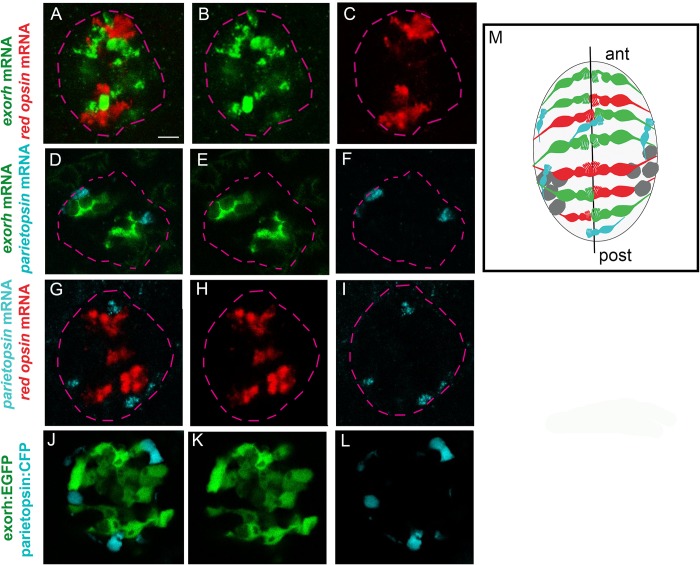
The zebrafish pineal gland contains three PhR subtypes.(A-I) Confocal sections of embryos double labeled for two of the three different opsin probes (exorh, PT, and red opsin). Nuclear staining (Topro3) was used to draw a mask delineating the pineal gland; these masks are shown on the panels (dotted pink lines). Embryos shown are 48 hpf. The images are falsely colored to show the exorh+ cells in green, the PT+ in blue, and the red+ in red. Anterior (“ant”) is on the top. Scale bar represents 10 μm. (J-L) Confocal sections of live Tg(exorh:EGFP)ja1;Tg(-2.2parietopsin:CFP) double-transgenic embryos (exorh:EGFP; parietopsin:CFP). Embryos shown are 96 hpf. (M) Schematic representation of the organization of the pineal gland with the orientation as in A-L. The midline is shown with a black line, projection neurons are in gray, and the color code for the PhRs is as in panels A-L. Underlying data can be found in S1 Data. exorh, exorhodopsin; hpf, hours post fertilization; post, posterior; PhR, photoreceptor; PT, parietopsin.